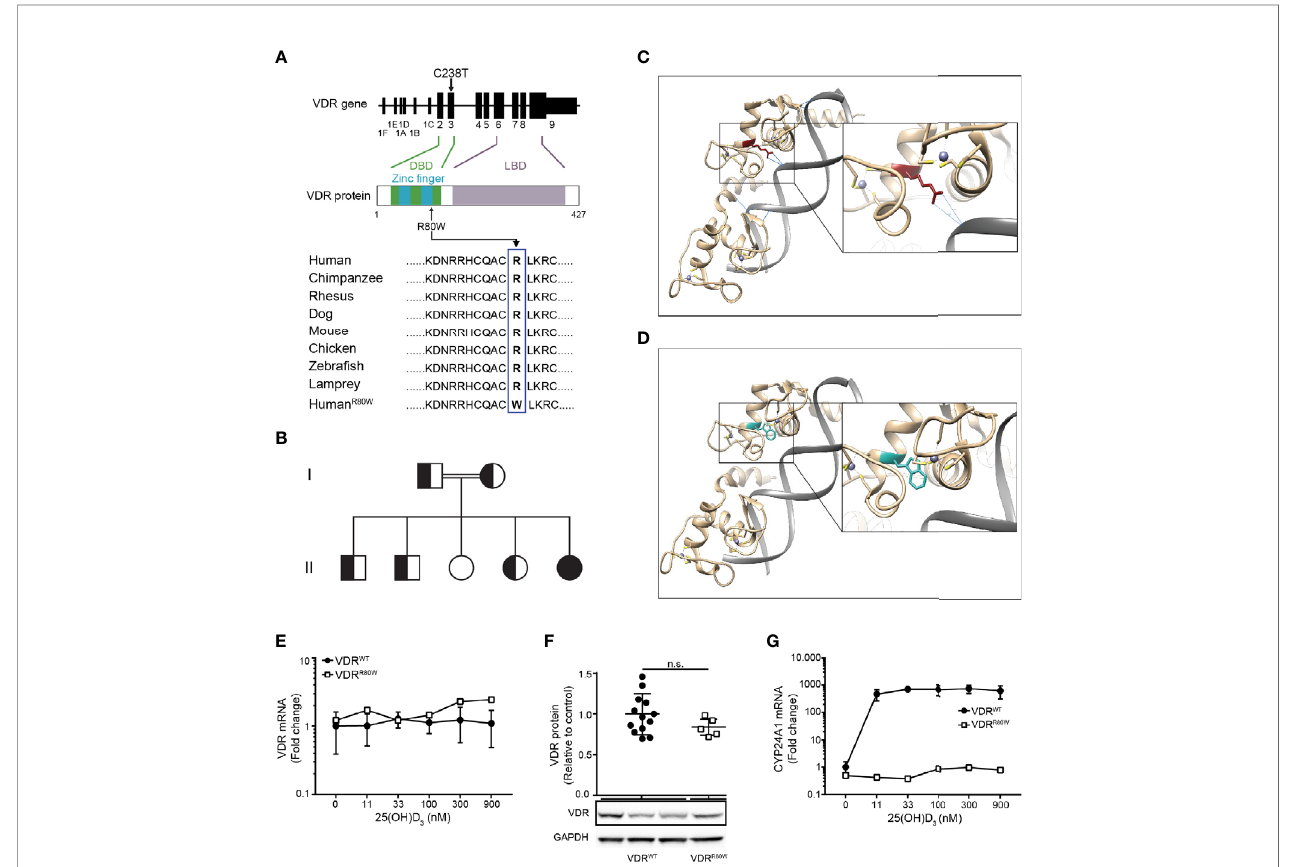
FIGURE 1 | The R80W mutation abolishes the transcriptional activity without affecting the structure or expression of VDR R80W (A) Localization of the C238T mutation to exon 3 in the VDR gene resulting in the R80W in the C-terminal part of the second zinc fi nger in the DBD of the VDR. The amino acids surrounding the R80 in the VDR from different species with the R80W at the bottom. (B) Family tree where circles represent females, squares represent males, homozygous VDR R80W marked as fi lled black, heterozygous VDR WT/R80W marked as fi lled black and white, and homozygous VDR WT marked as fi lled white. (C, D) In silico structure of the zinc fi ngers of the VDR interacting with DNA. (C) VDR WT with the R80 in red and with the hydrogen bonds between R80 and the DNA backbone indicated as blue lines. (D) The same region of VDR R80W with the W80 in blue. (E) VDR mRNA, (F) VDR protein and (G) CYP24A1 mRNA in VDR WT (black circles) and VDR R80W (white squares) CD4 + T cells activated in the presence of the indicated concentration of 25(OH)D 3 . (E – G) The expression levels are given as fold change normalized to the average expression level of VDR WT in control cells activated in the absence of 25(OH)D 3 . (E) Mean ± SD (VDR WT n = 6; VDR R80W n = 1). (F) Relative VDR protein expression as determined by the density of the VDR bands from Western blotting analysis of VDR WT and VDR R80W . The upper panel gives the density of VDR R80W (white squares) normalized to the average density of VDR WT (black circles) from control cells. The lower panel shows one representative Western blotting analysis out of fi ve independent experiments of VDR and GAPDH (loading control) from three controls and the patient. Mean + SD (VDR WT n = 13; VDR R80W n = 1 repeated 5 times). (G) Mean ± SD (VDR WT n = 3; VDR R80W n = 1). n.s. means not signi fi